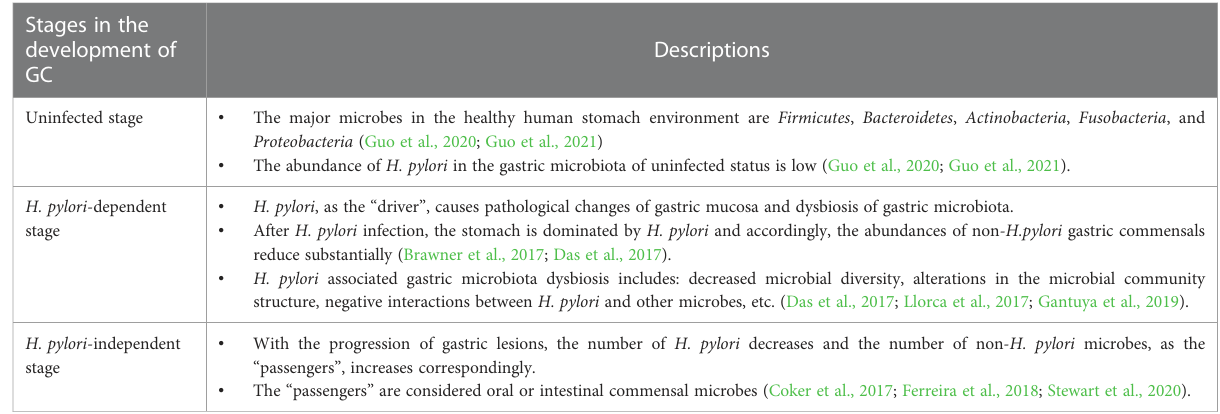
TABLE 2 Key roles of H. pylori in gastric